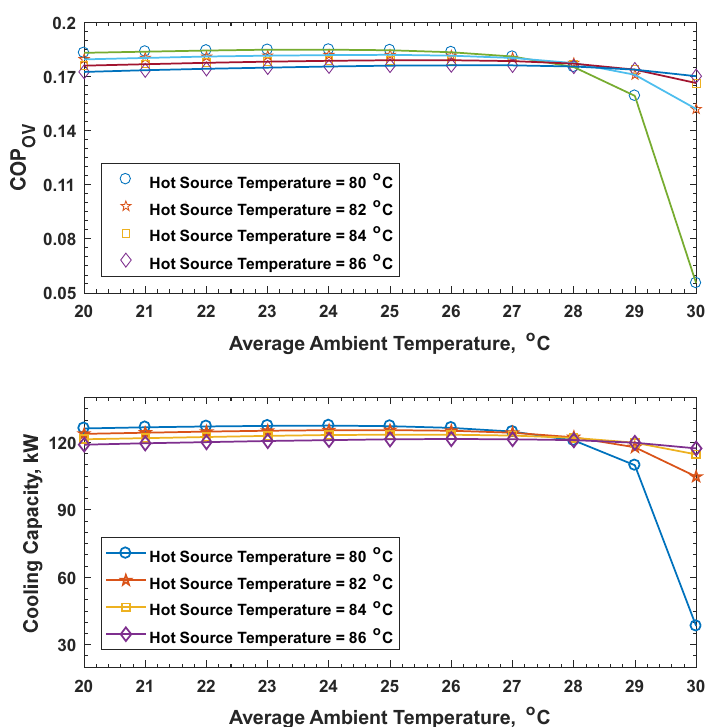
Figure 12. Effect of average ambient temperature on the performance of the overall system.